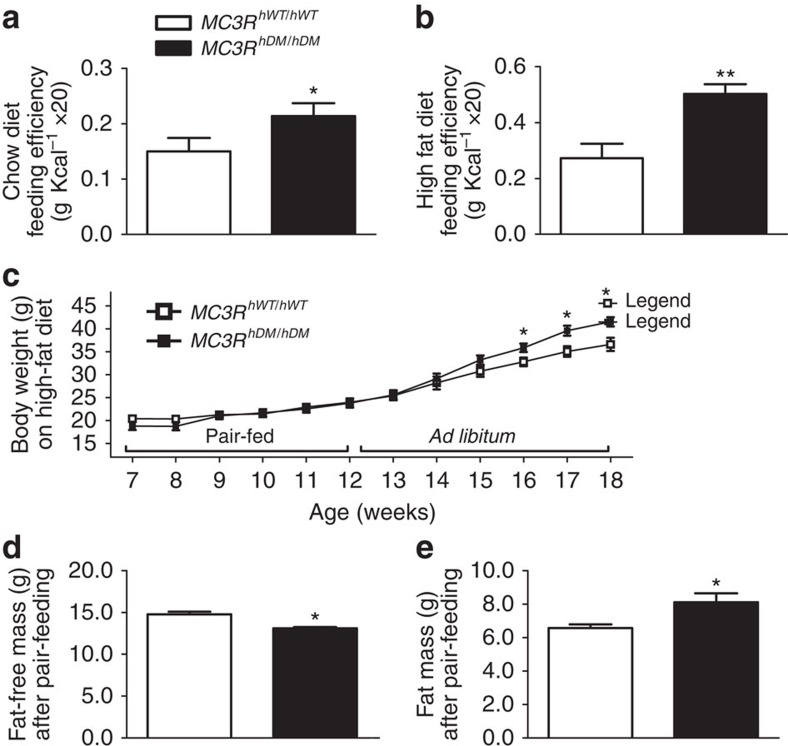
Increased feeding efficiency in MC3RhDM/hDM mice.Feeding efficiency (the ratio of body weight to energy intake (g Kcal−1) × 20) was determined in female MC3RhWT/hWT (open bars) and MC3RhDM/hDM (closed bars) mice during (a) 5 weeks of chow diet feeding or (b) 7 weeks of high-fat-diet feeding. (c) For the high-fat pair-feeding study, the daily energy intake (11.83 Kcal per day) of 7- to 8-week-old female high-fat-fed MC3RhWT/hWT mice (n=7) was supplied to the age matched female high-fat-fed MC3RhDM/hDM mice (n=5), and their body weight change was monitored weekly. (d,e) Body composition of MC3RhWT/hWT and MC3RhDM/hDM mice was determined immediately after the end of pair-feeding period at age 12–13 weeks. Data are represented as mean±s.e.m. *P<0.05 and **P<0.01 MC3RhDM/hDM versus MC3RhWT/hWT mice. Groups were compared by Student's t-tests (two-tailed) (a,b,d and e) and two-way analysis of variance followed by Bonferroni post-tests (c).